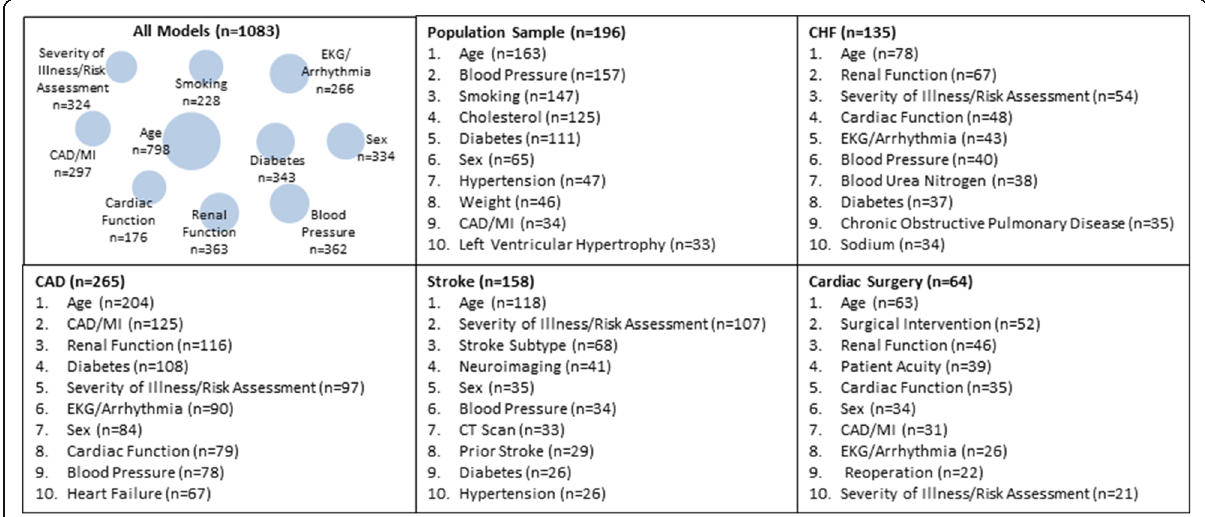
Fig. 5 Frequency of covariate categories among all covariates ( n = 9641) in the Tufts PACE CPM Registry. Top covariates across the top 5 index conditions are also presented